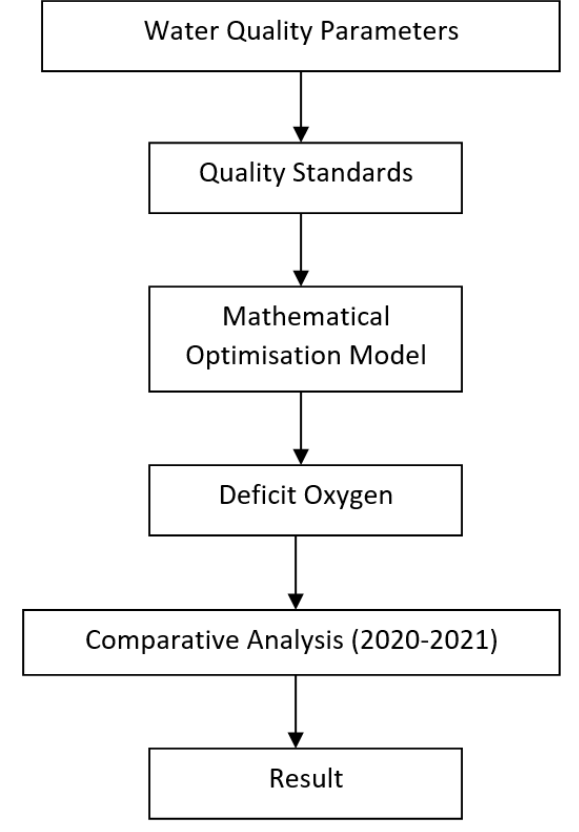
Figure 2. Experimental methodology.